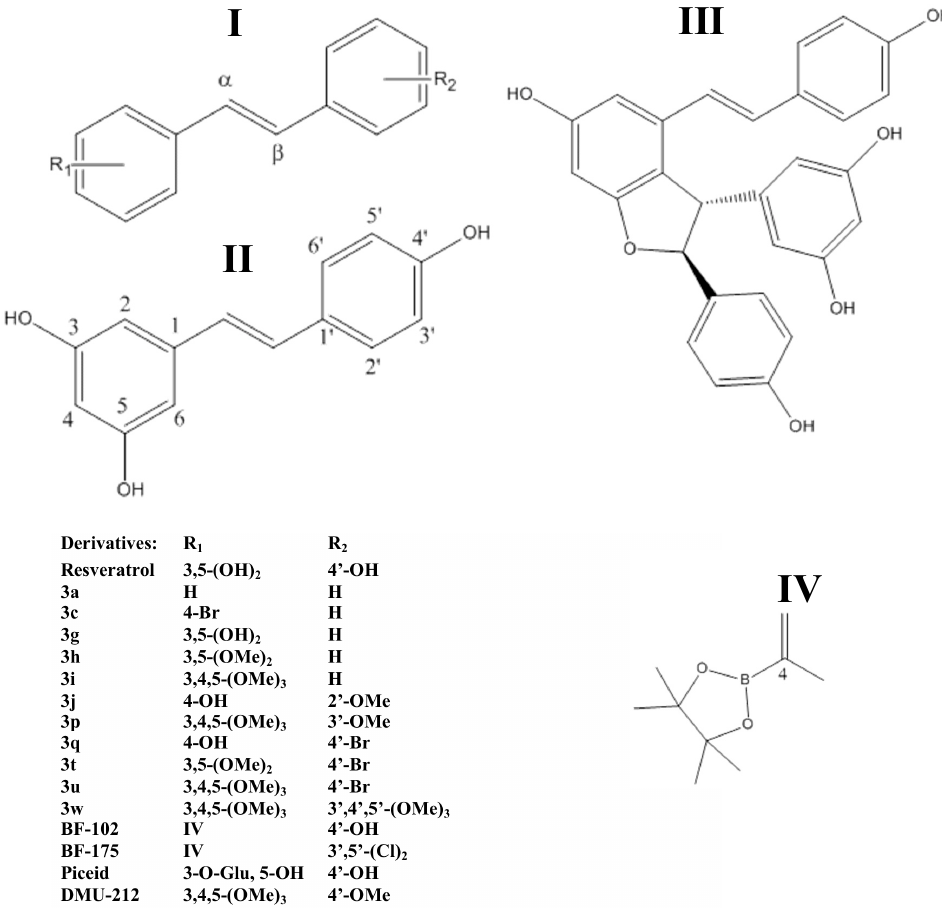
Figure 4. Representative structures for stilbenes: ( I ) basic (E) -stilbene structure, R 1 and R 2 are presented in order to indicate further substitution patterns; ( II ) representative structure for trans -resveratrol substitution pattern, indicating numbering; ( III ) ε -viniferin; ( IV ) 4-(4,4,5,5-tetramethyl-1,3,2-dioxaborolane) substituent group. Substitution patterns for some derivatives are included.